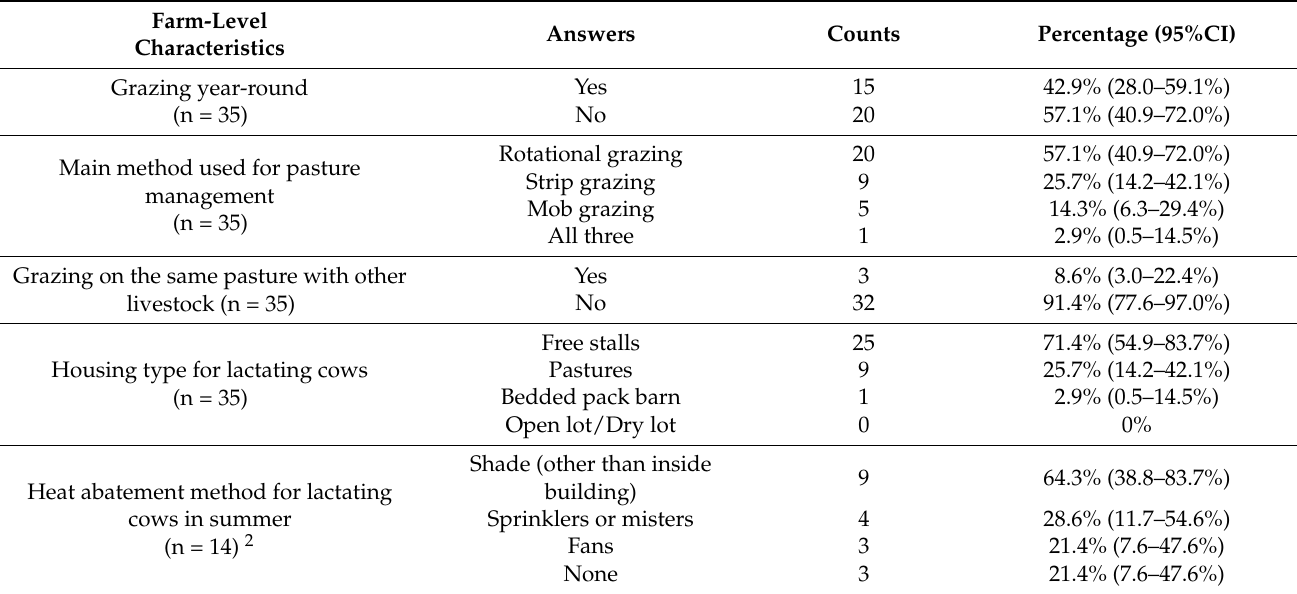
Table 2. Pasture and housing management (n = 35 farms 1